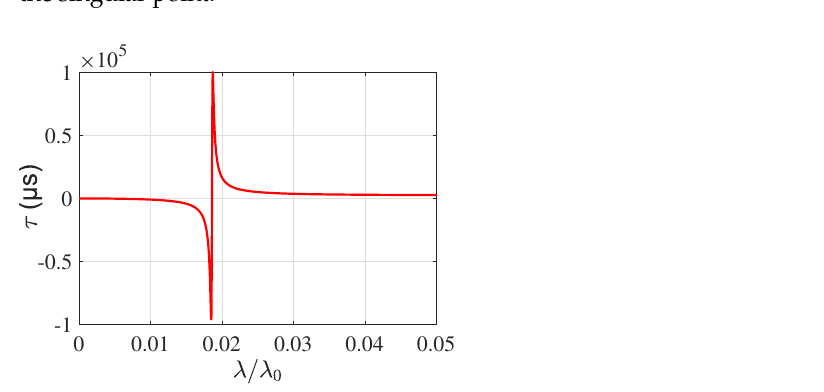
Figure 9. The group delay time τ of probe output field at resonance δ ω / ω 1 = 0 as a function of the Coulomb coupling constants λ between two NRs, in which γ 2 = − γ 1 , κ = 0.1 κ 0 , η = 1/2, P = 2 mW. The other parameters are the same as given in Figure